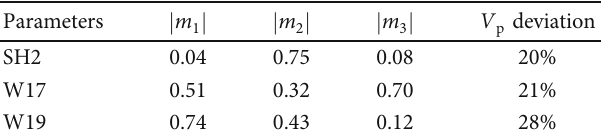
Figure 11: Comparison of V and V from site SH2 based on di ff erent models (original boreholes): (a) V p s di ff erent models, and (c) density of model and SH2. Model 1 is a pore- fi lling model, Model 2 is a thermodynamic elastic model, Model 3 is a particle cementation model, SH2 is a measured drilling curve, and Model 4 is a modi fi ed model; SH2 is a measured drilling curve, and Model is the estimated results. Table 3: The heterogeneous reservoir model parameters at the three boreholes (SH2, W17, and W19).